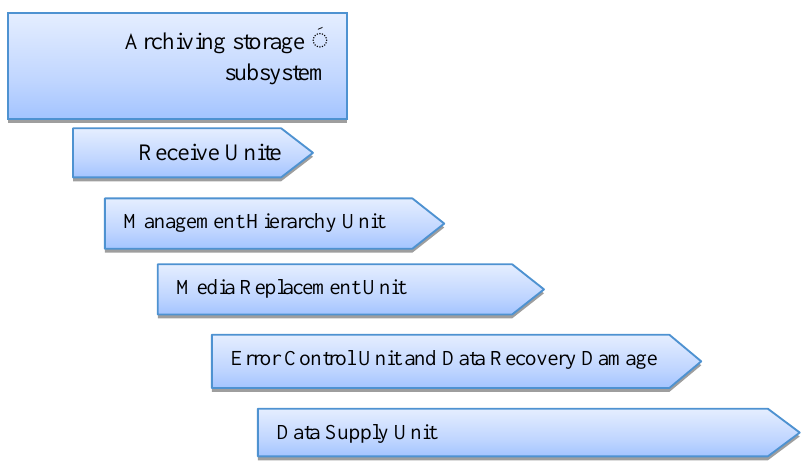
Figure 2. Archiving Subsystem